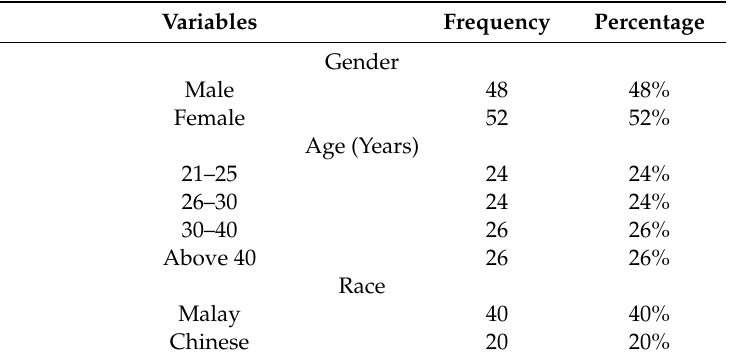
Table 1. Socio-demographic characteristics of study